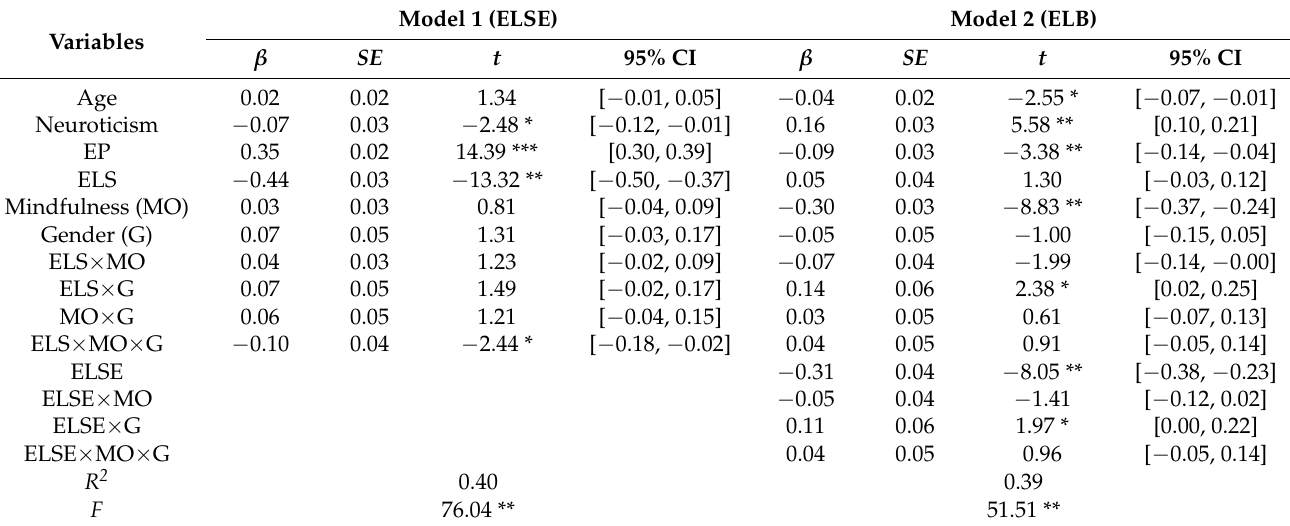
Table 3. Testing for moderated mediation.